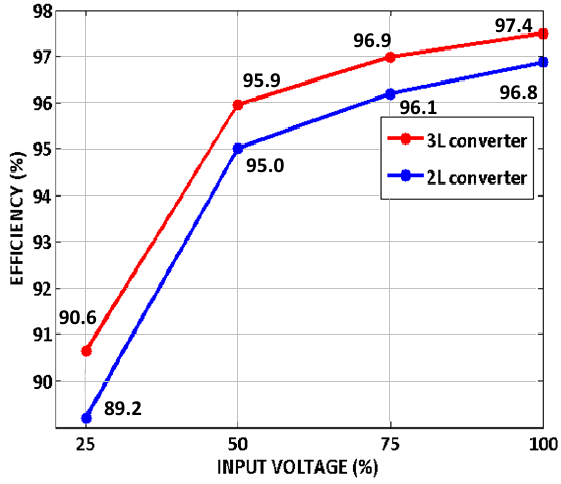
Figure 8. Converter efficiency from simulation measurements.